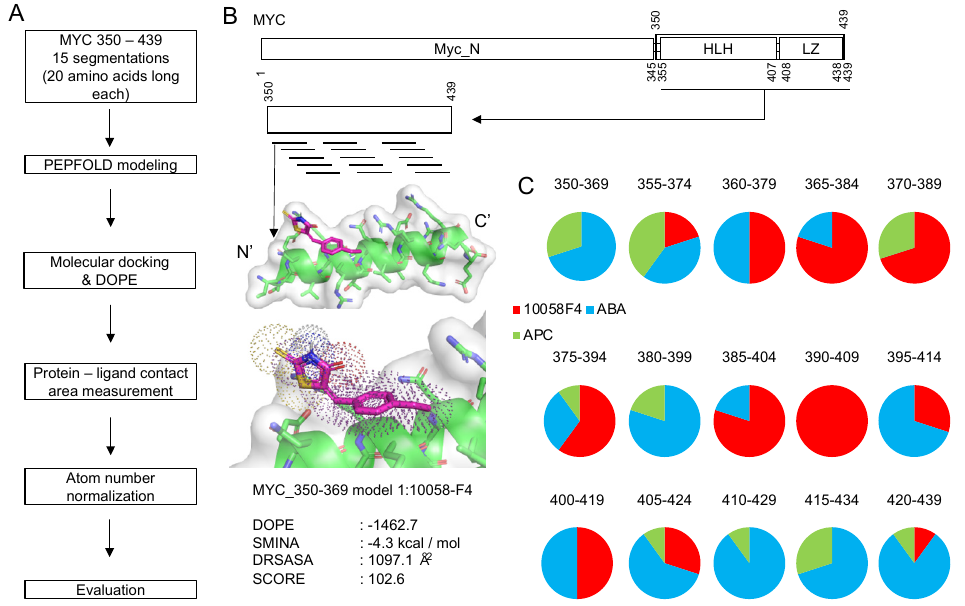
Figure 2. Peptide molecular docking procedure and its application to 10058F4 and other disorder-to-order transition region inhibitors (ABA and APC targeting MYC 350–439 region 15 peptide groups (Figure 1). ( A ) The procedure of target region segmentation and molecular docking toward generated peptides. ( B ) A workflow diagram following the procedure described in plot A. ( C ) Application of the method in the analysis of 10058F4, ABA, and APC interactions with 15 peptide groups derived from the MYC 350–439 region and pie charts showing distribution of the 10 best docking results for each peptide